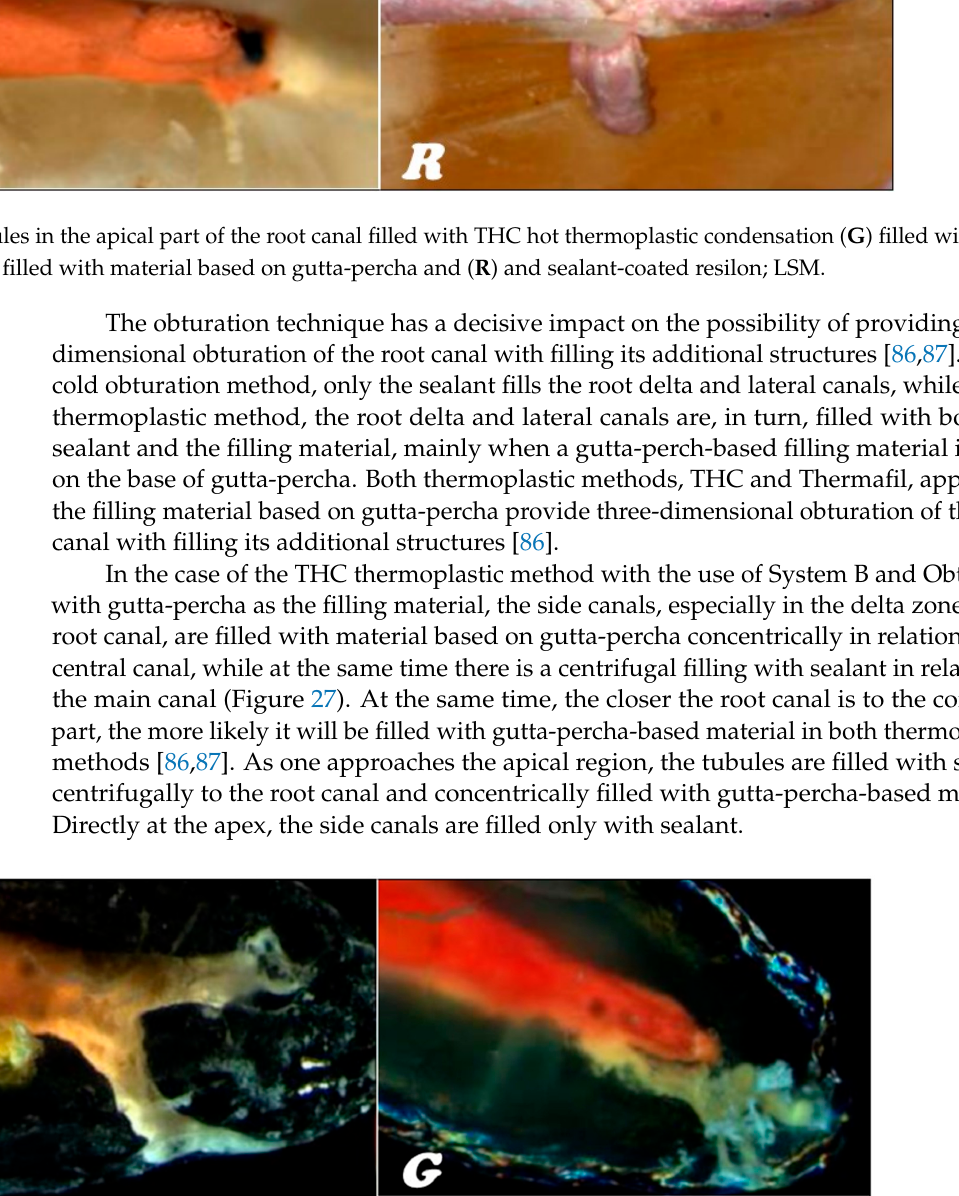
Figure 28. Picture of the leak on the border of the sealant and the dentin of the root canal filled with filling material ( G ) based on hot gutta ‐ percha using the thermoplastic technique THC; ( R ) resilon through cold lateral condensation; SEM. Leaks in the case of obturation using a gutta ‐ percha ‐ based material have a width in the range of 1.061 ‒ 8.131 μ m, while in the case of using resilon they reach 3.535 ‒ 7.070 μ m (Figure 29). These leaks can occur on the border of the filler material where the sealant and the root dentin have not been found, as well as in the sealant layer itself, closely con ‐ nected on one side to the root dentin and on the other side to the filler material.